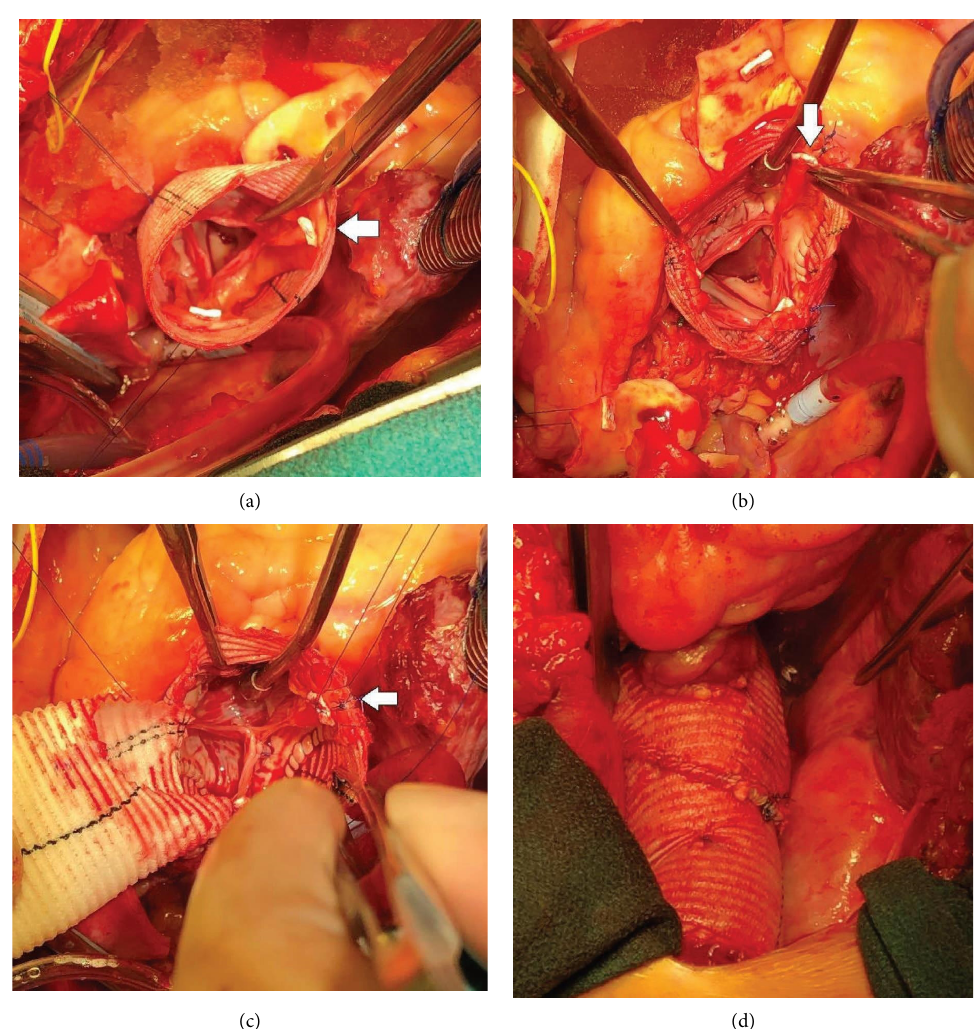
Figure 5: Example of a patient with a tall right-non commissural post (arrow) which is 2cm taller than the left-right and the left-non commissural posts (a, b); anatomic variants such as this might be more easily accommodated when using the two-graft technique (c,